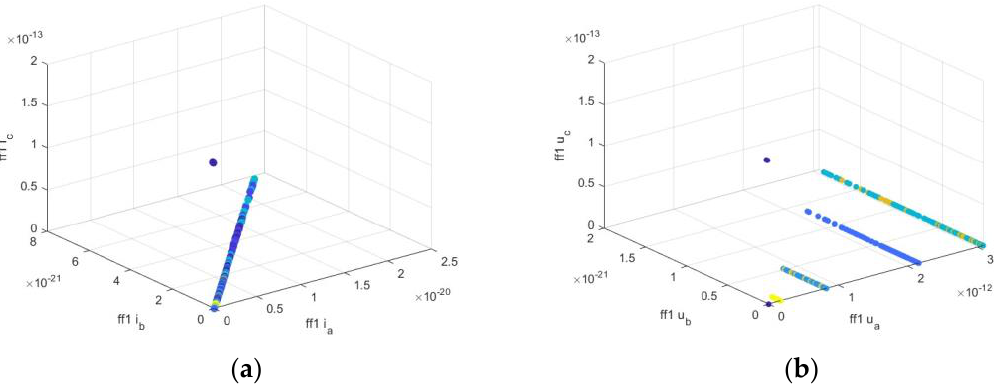
Figure 14. Dependence of the first-order harmonic amplitude of the fast Fourier transform of the ( a ) currents 𝑖 𝑎 , 𝑖 𝑏 , 𝑖 𝑐 and ( b ) voltages 𝑢 𝑎 , 𝑢 𝑏 , 𝑢 𝑐 .